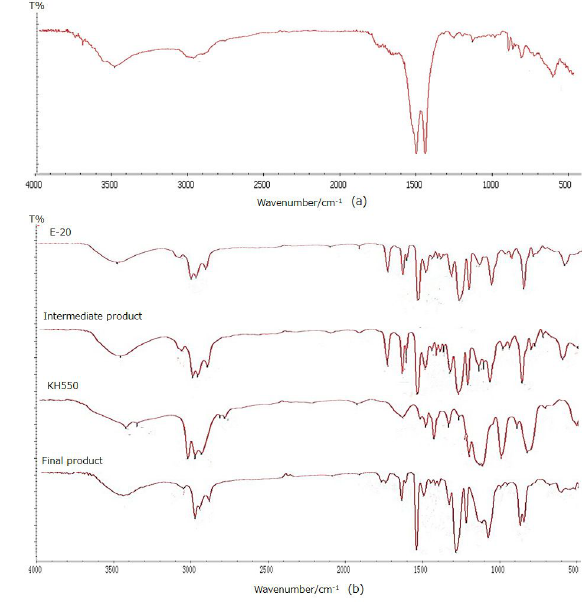
Figure 2: FT-IR spectrum analysis of different substance (a) corro- sion product (b) reactants and modified product